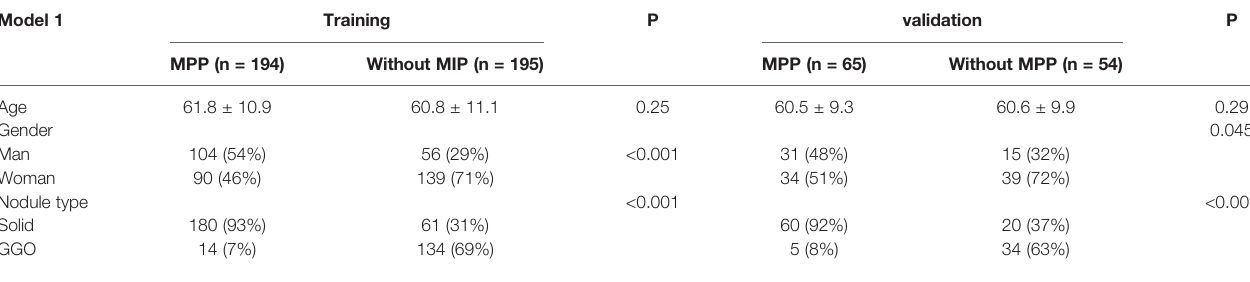
TABLE 1 | Demographic and clinical characteristics of patients on different datasets of model 1.